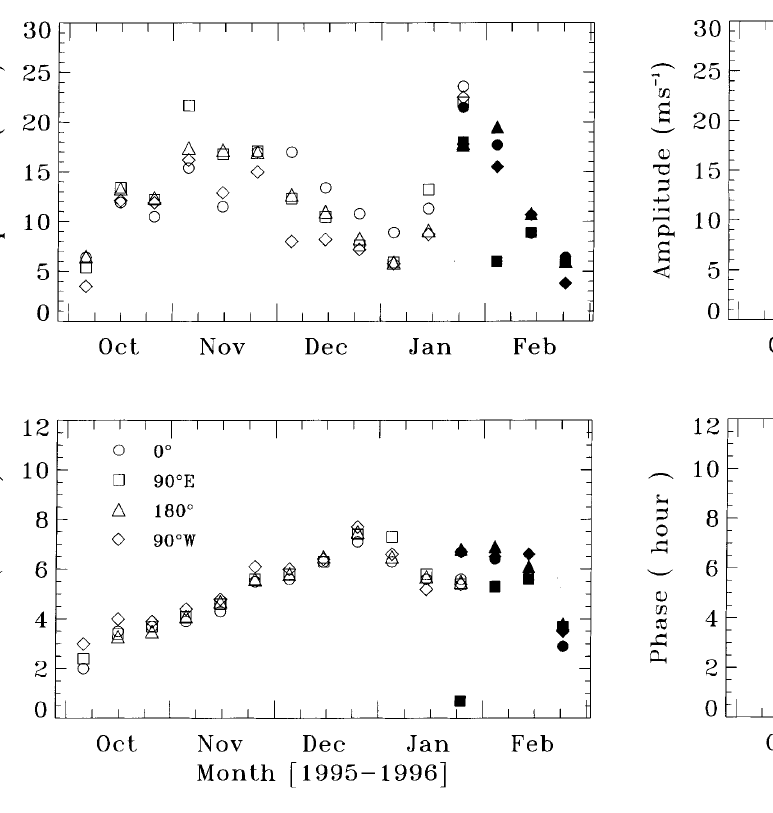
Fig. 3. Same as Fig. 2, except for November